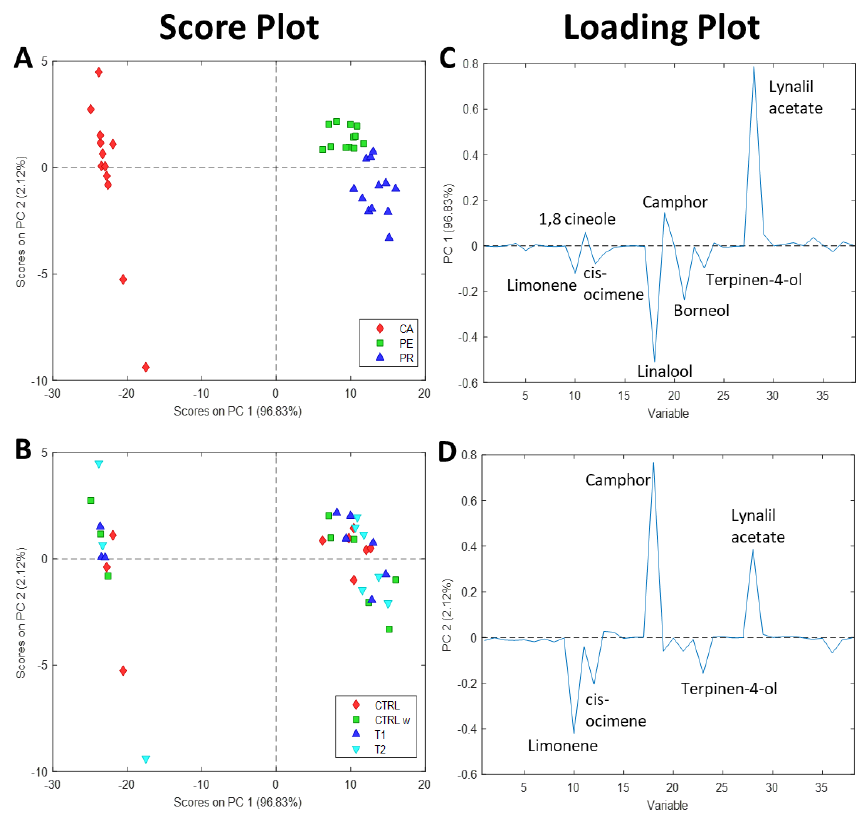
Figure 1. Score plot of principal component analysis (PCA) labeling the farms ( A ) and the treatments ( B ), and loading plots on PC1 ( C ) and PC2 ( D ). CA, Campazzo; PE, Pedroni; PR, Preci; CTRL, farm control; CTRL W, foliar application of water; T1, foliar application of FITOSTIM; T2, foliar application of FITOSTIM ALGA.